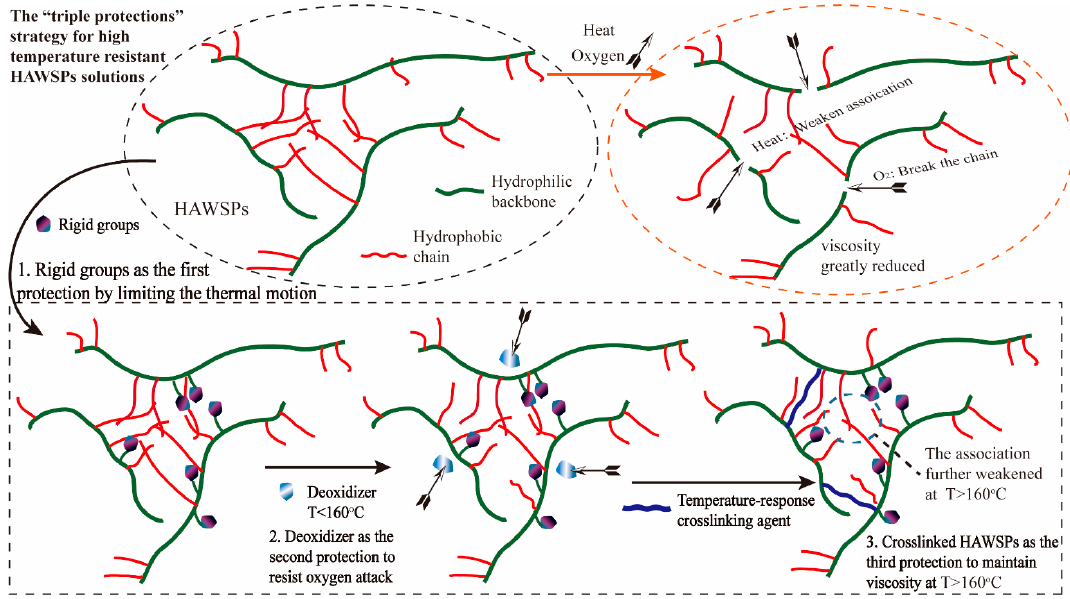
Figure 1. Schematic of the “triple-protection” strategy to enhance the high temperature resistant performance of hydrophobic associative water-soluble polymers (HAWSPs).